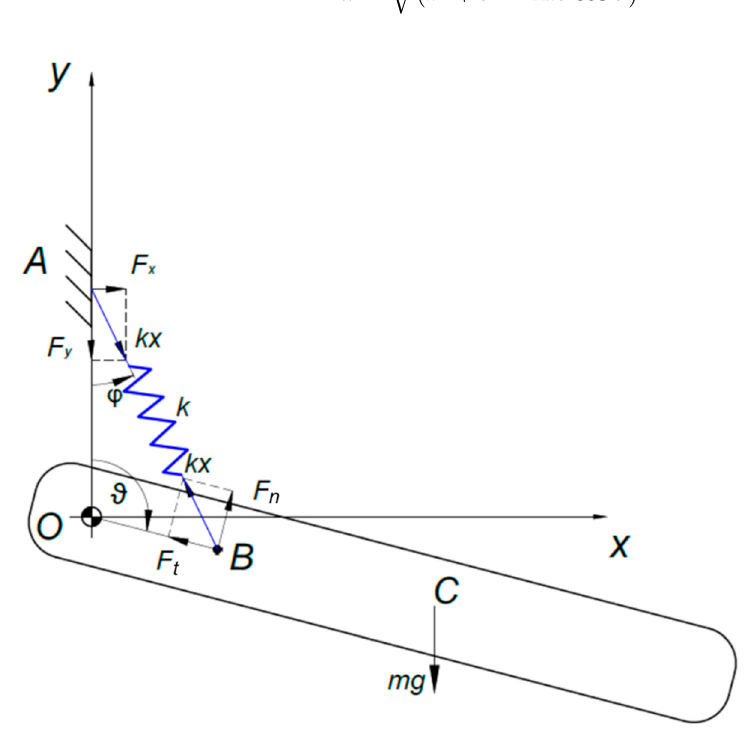
Figure 2. Analysis of the forces applied by the spring to the link and frame.